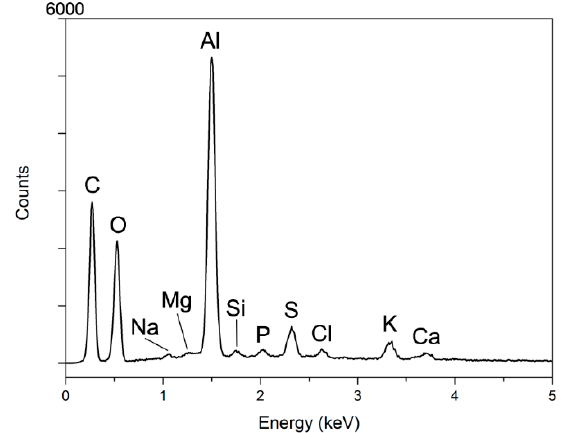
Figure 7. Energy dispersive X-ray spectroscopy analysis performed on a micrometer particle of ML dispersed in the varnish layer of P4 sample.